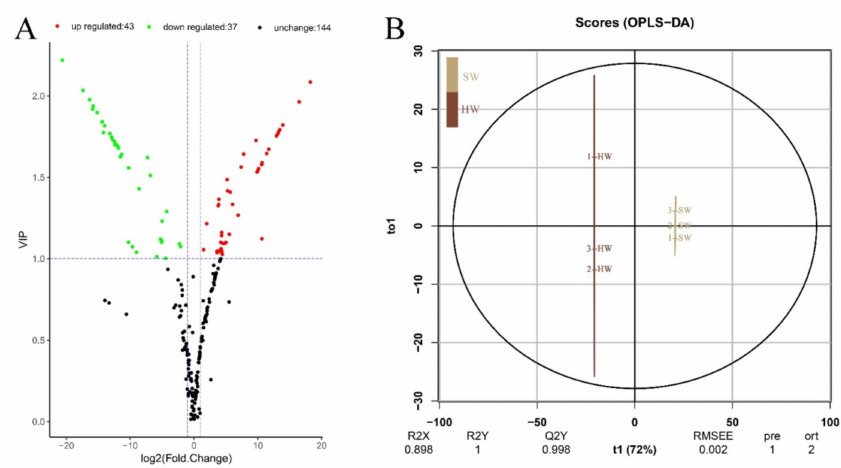
Figure 3. ( A ) The volcano plot of the di ff erential metabolites in the heartwood and sapwood. Green dots represent down-regulated metabolites, red spots represent up-regulated metabolites, and gray dots represent insignificant di ff erences in metabolites. ( B ) OPLS-DA model plot of the di ff erential metabolites in the heartwood and sapwood. Table1. Thetop10metabolitesthatweresignificantlyup-regulatedinheartwoodcomparedtosapwood.